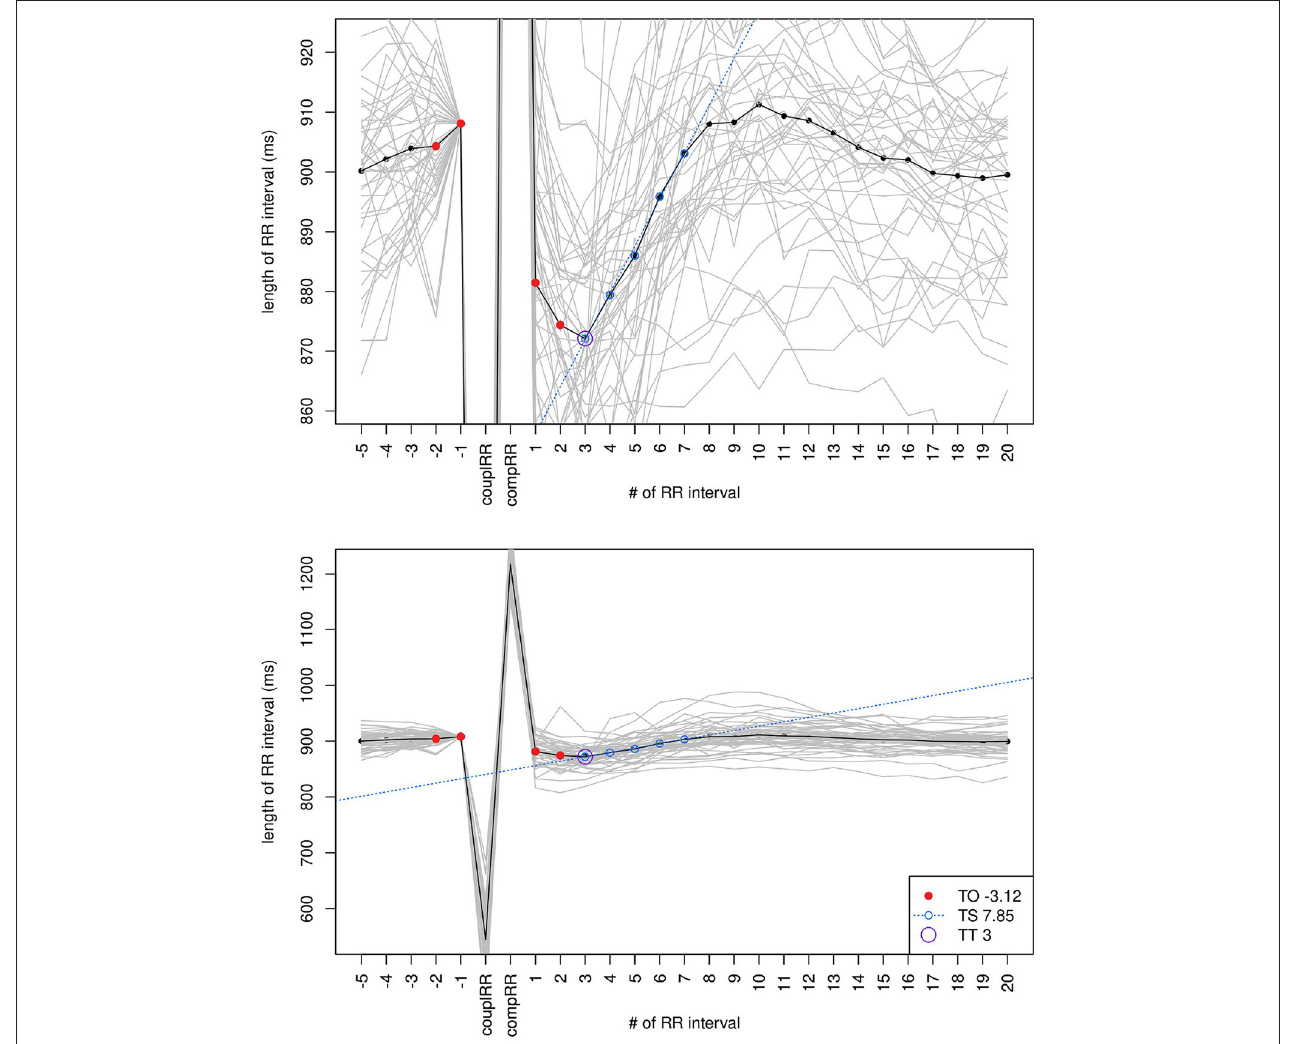
FIGURE 4 | The stVPCS calculated from 47 files that matched all filter criteria and had the best HRV parameters.